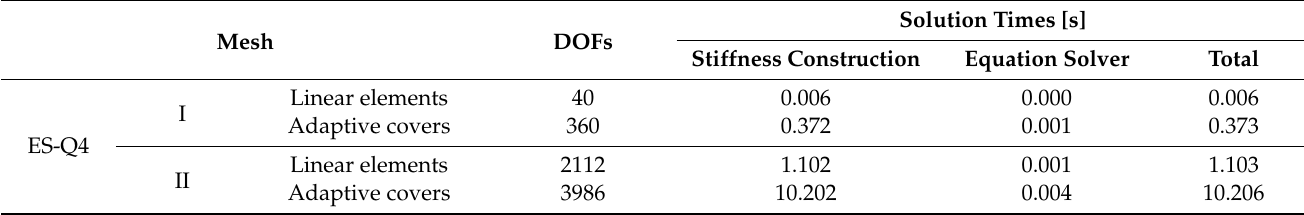
Table 2. Solution times (in seconds) for constructing the stiffness matrix and solving linear equations for the Cook’s skew beam